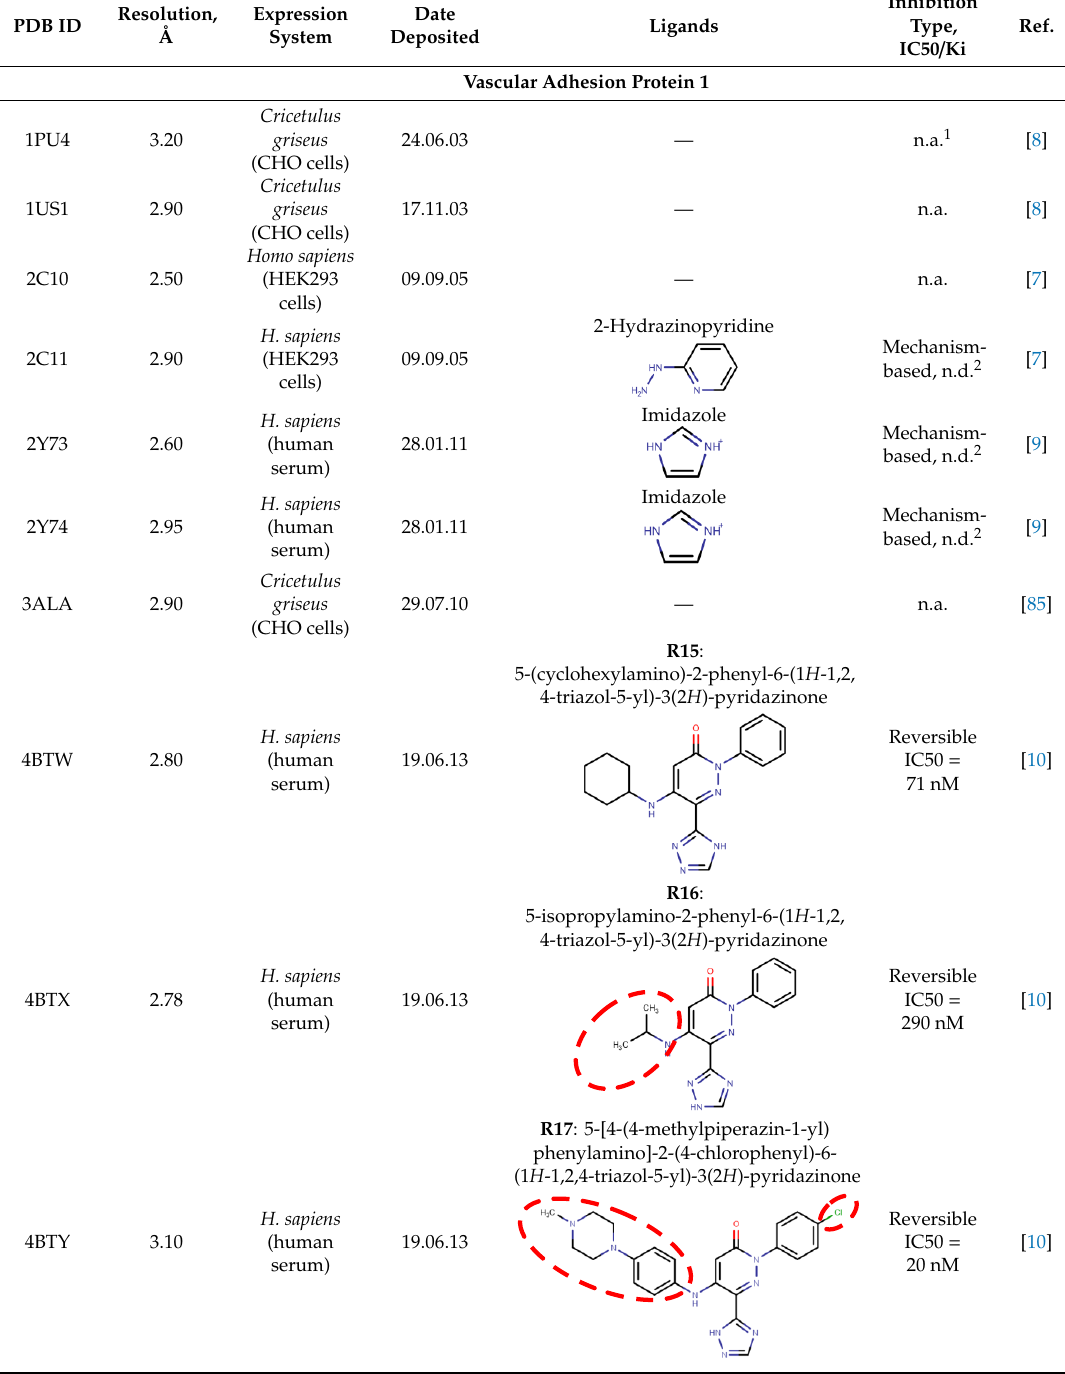
Table 3. A comprehensive list of experimentally solved structures of hVAP-1 and diamine oxidase (DAO) deposited into the Protein Data Bank as of 15 January 2020. PDB ID